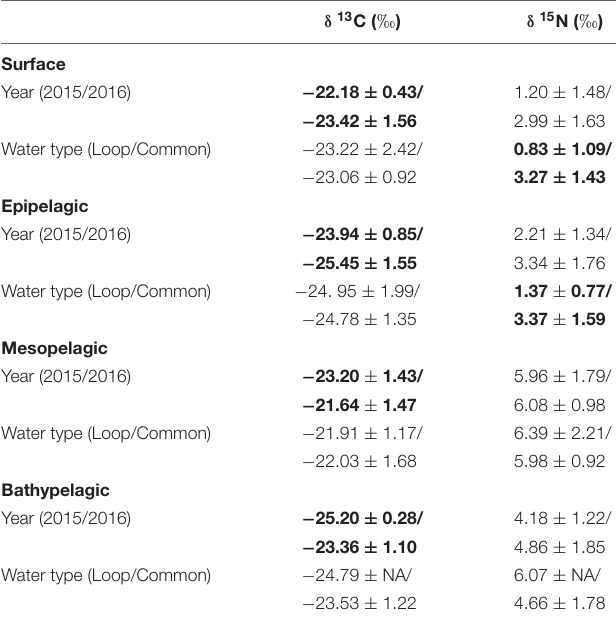
TABLE 3 | Mean ( ± SD) δ 13 C and δ 15 N stable isotope ratios of particulate organic matter among sampling years (2015/2016) and water types (Loop Current/Common